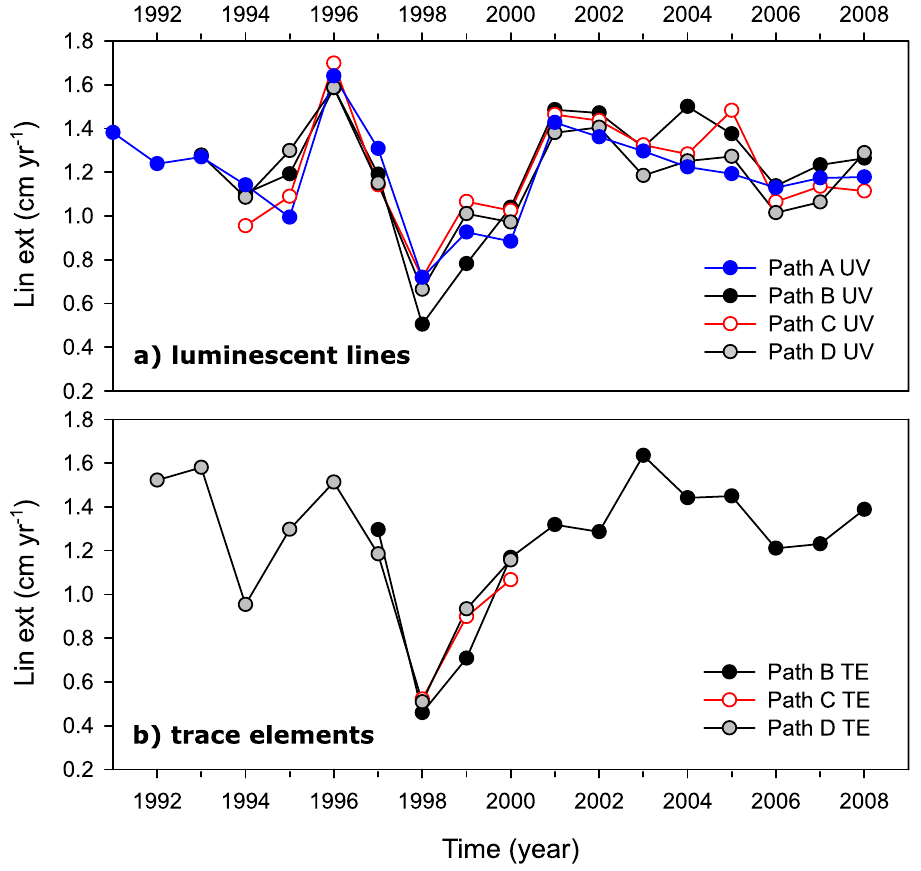
Figure 2. Annual records of skeletal growth measured as linear extension from: ( a ) luminescent lines sampled along all four sample paths and ( b ) TE ratios sampled along three different paths. Path B and Path D were sampled along the axis maximum growth axis but from different slabs, with Path B sampled closer to a small scar observed during the summer of 1998 (Fig. 1). Path A and Path C were sampled along the same sub-optimal growth axis but different